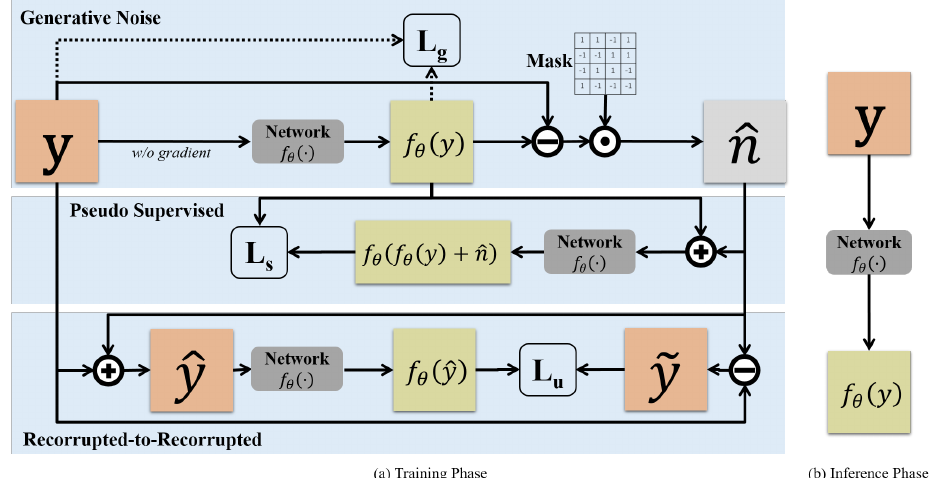
Figure 1. The framework of generative recorrupted-to-recorrupted (GR2R). ( a ) Overall training process. y is the observed noisy image, the generative noise ˆ n in pseudo supervised (PS) and Recorrupted2Recorrupted (R2R) is obtained by element-wise multiplication of random mask m